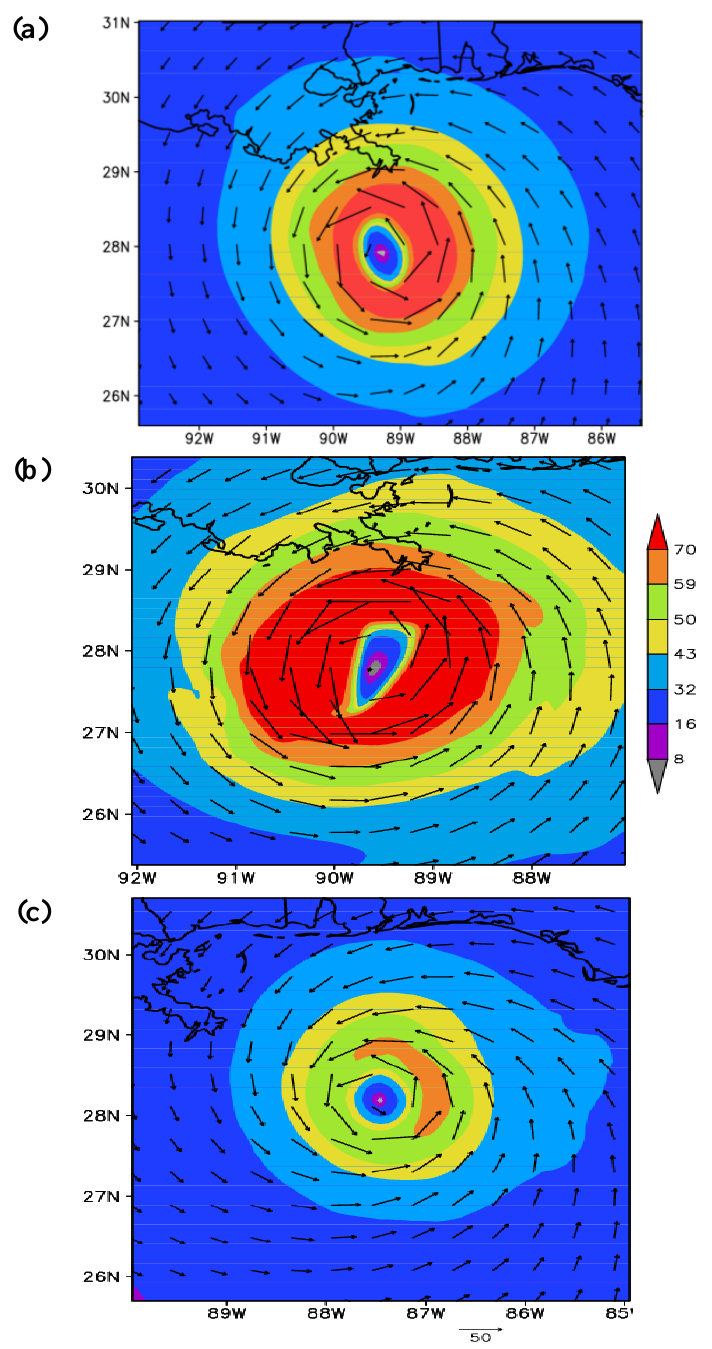
Figure 6. Horizontal wind flow (black vectors) and wind magnitude (m/s-shaded) at 925 hPa level corresponding to the time of mature stage for (a) HWRF at 1200 UTC 28